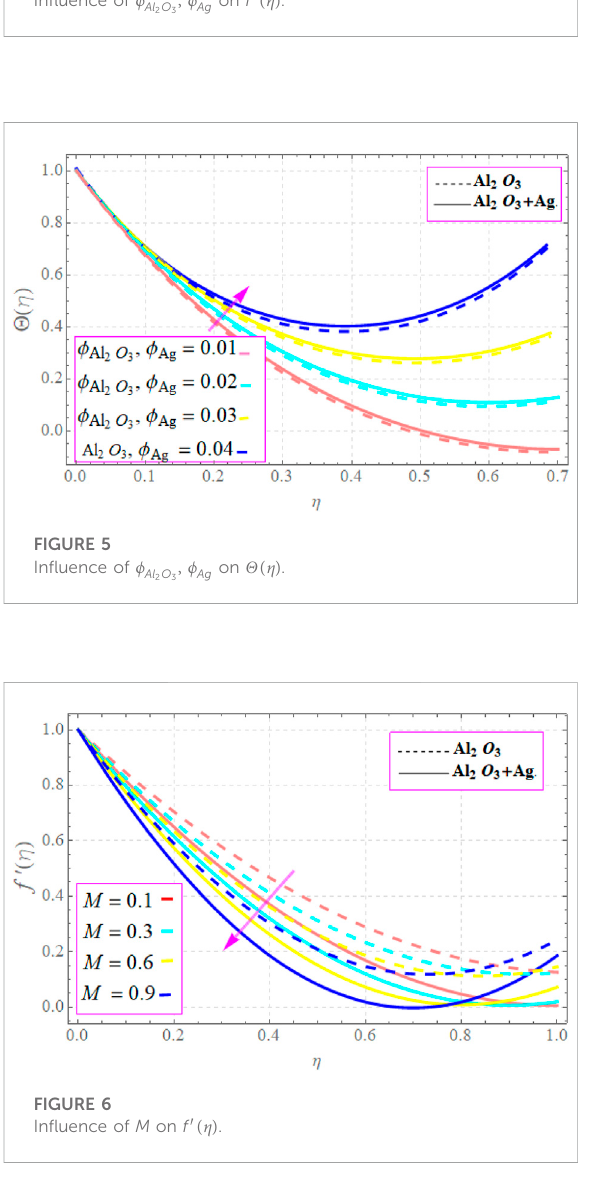
FIGURE 7 In fl uence of E on f ′ ( η ) .